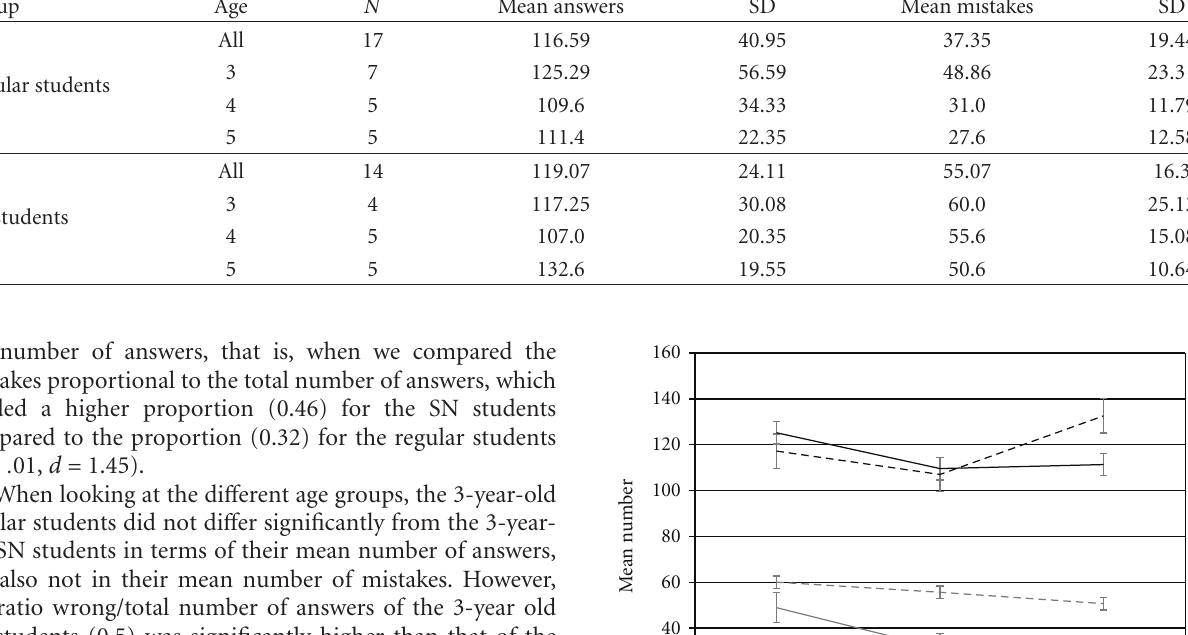
Table 2: Means and standard deviations of the number of answers and mistakes per group of students (regular and SN) and cohort. Group Age N Mean answers